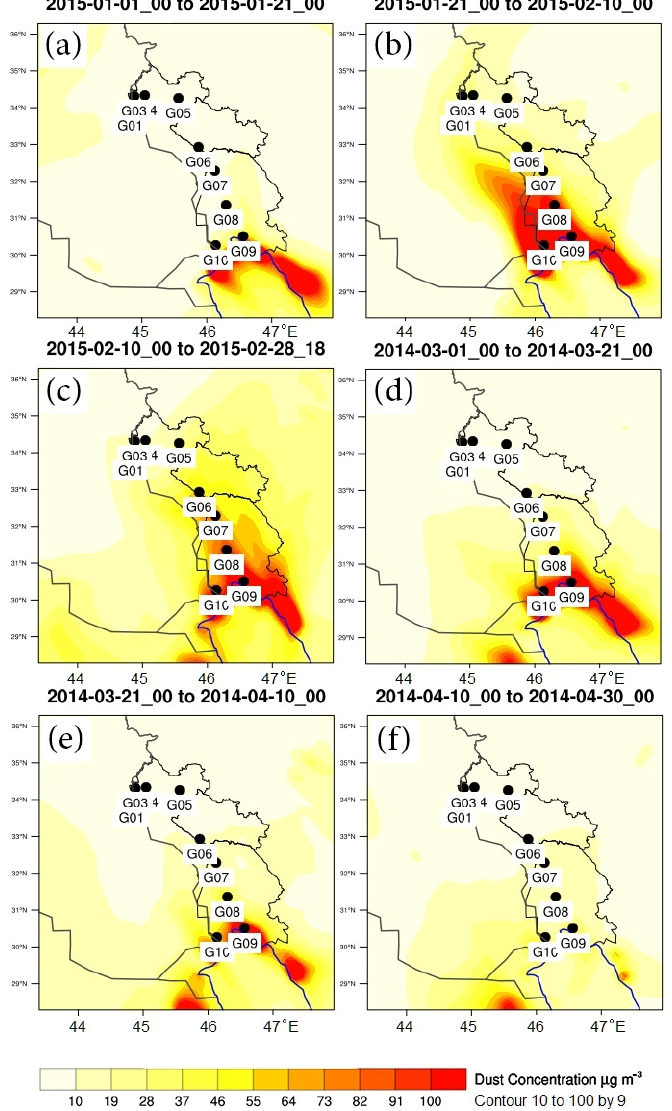
Figure 9. WRF-Chem results for concentrations ( µ g m − 3 ). Outputs of the weather simulations are set with an interval of 1 hour. To enhance the existing data visualization, each image in ( a – f ) represents a 20-day average value of the dust concentration.